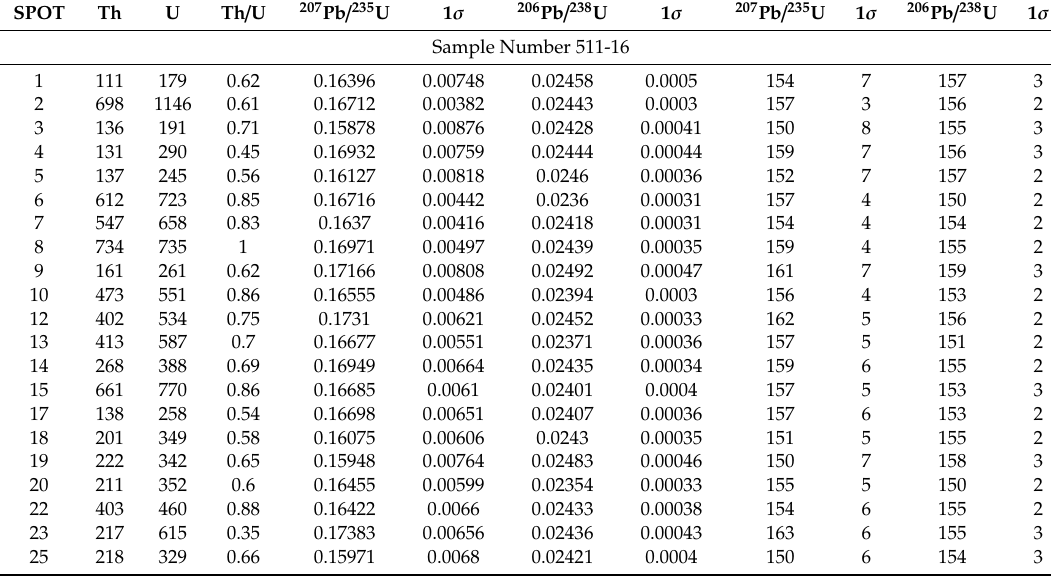
Table 2. Re–Os isotopic data for molybdenites from the Jiangjiatun Mo deposit.